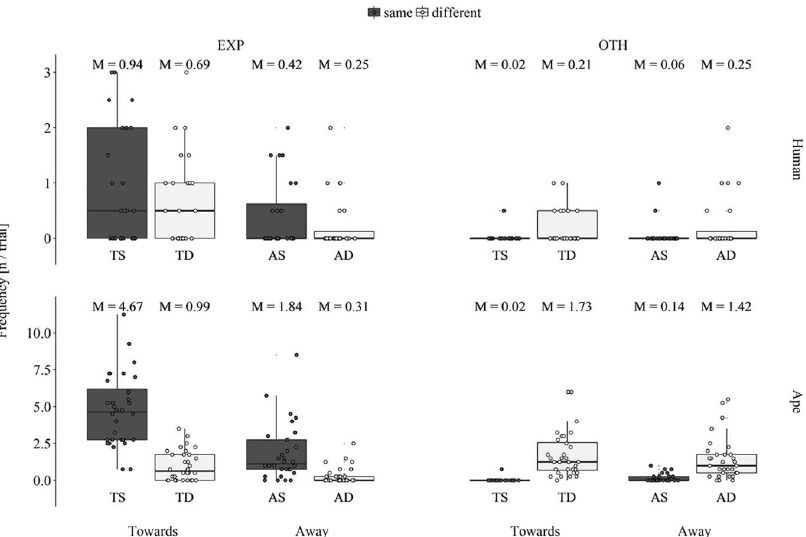
Fig 3. Box plot of the averagenumber of visual gestures per trial that human infants (upper row) and apes (lower row) produced on the experimenter’s side (EXP: left column) and the other side (OTH: right column) acrossthe factors orientation (Towards: two leftmost boxes in each plot, Away: two rightmost boxes in each plot) and location (red: experimenter and reward are on the sameside, blue: experimenter and reward are on different sides) resulting in the four experimental conditions towards- same(TS), towards-different (TD), away-same (AS) and away-different (AD); M: condition mean value, the middle line of each box represent population median values (different from the M above each box); lower and upper hinges display first and third quartiles, respectively; whiskersextend up to 1.5 x interquartile range, small circlesrepresentindividual data